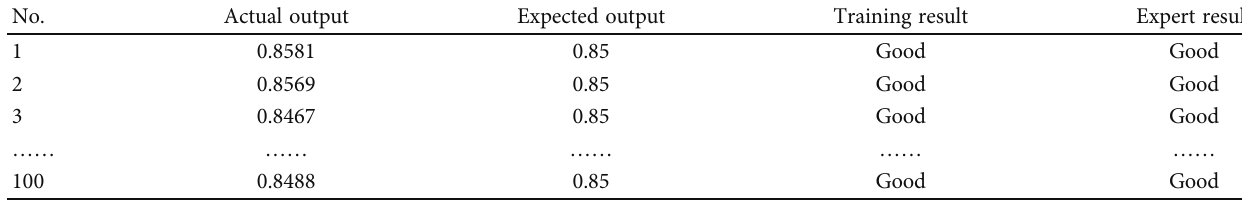
Table 14: Training results of some